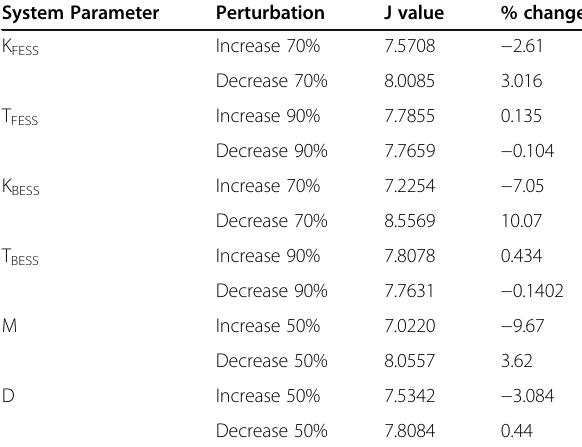
Table 9 Percentage change in J value under sensitivity